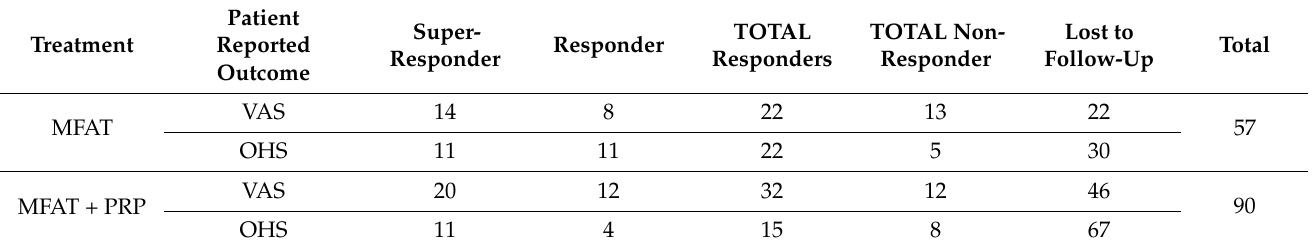
Table 3. The numbers of super-responders, responders, and non-responders according to criteria for Oxford hip score (OHS) for function, and visual analogue scale (VAS) for